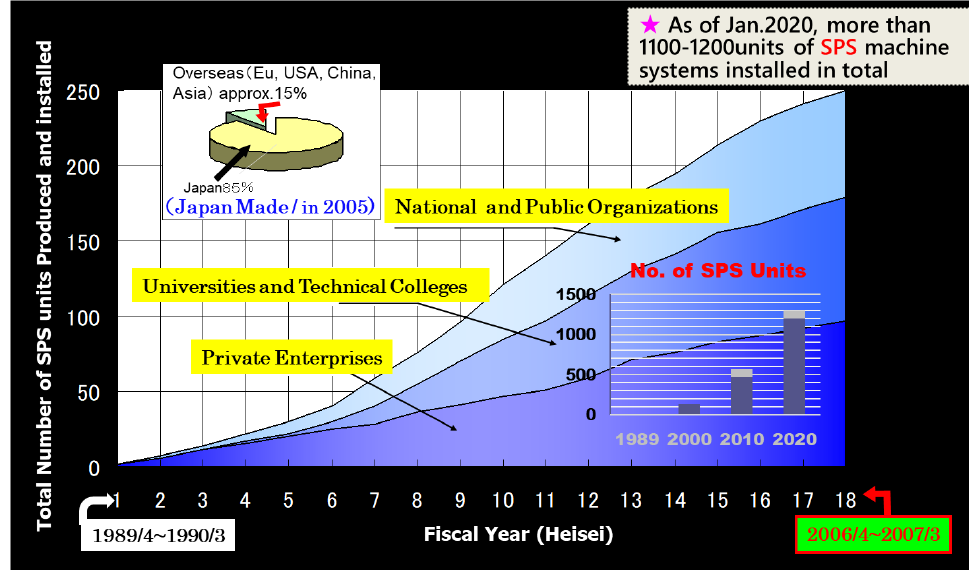
Figure 3. Increasing use of the SPS machines in the world: the graph of right corner: estimated SPS units produced and installed during October 1989–January 2020; upper left corner: situation of made in Japan SPS apparatus in 2005.